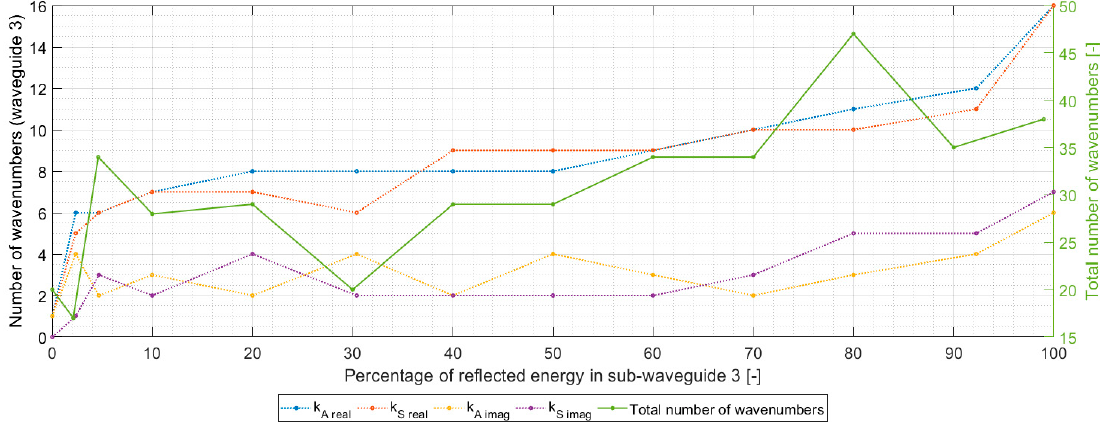
Figure 7. Number of real/pure imaginary wavenumbers in sub-waveguide 3 versus the percentage of reflected energy prescribed in the considered sub-waveguide.